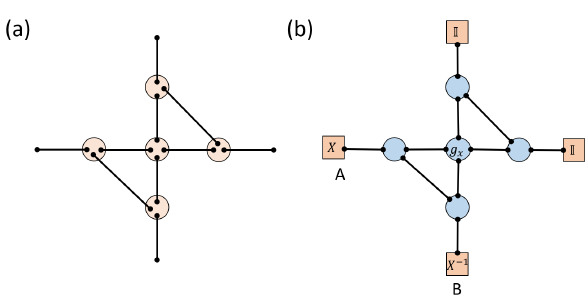
Figure 1 . (a) Illustration of the random tensor network. An EPR pair is defined for each link (line with dots), and a projection is applied to each vertex (circles). (b) The permutation spin model that computes the Rényi negativity of a random tensor network. Each vertex carries a permutation group element g x ∈ S k , and the boundary condition is defined by g x = X on A , g x = X − 1 on B and g x = I elsewhere, where X is a k -cycle (see